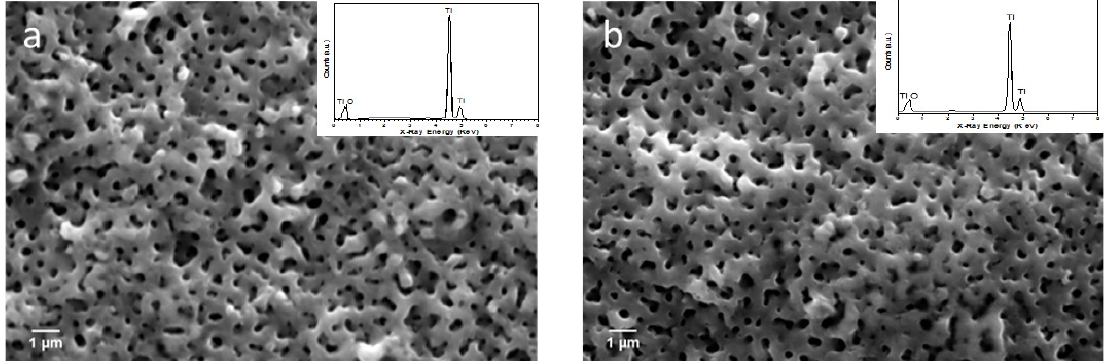
Figure 1. Scanning electron microscopy (SEM) micrographs and energy-dispersive X-ray spectroscopy (EDX) analysis (inset) of sample ( a ) S0 and ( b ) S6.